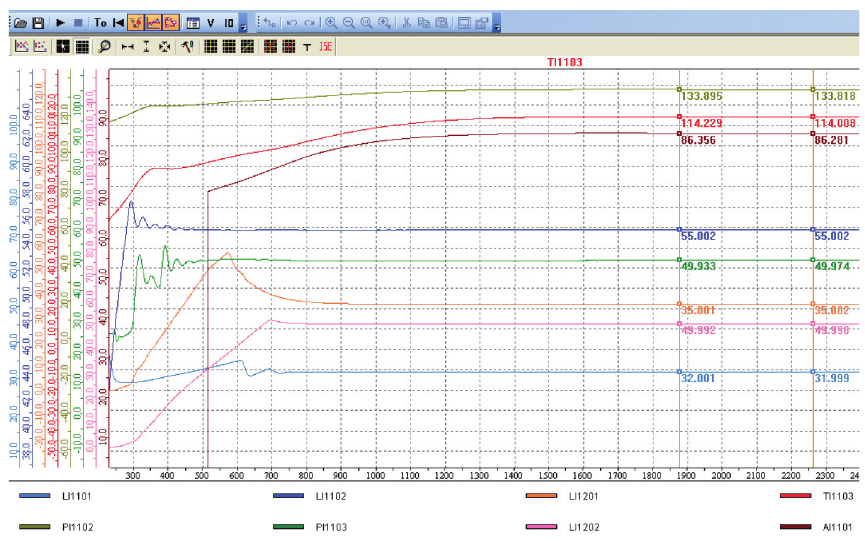
Figure 15: Improved automatic disturbance rejection control b � 0.058.